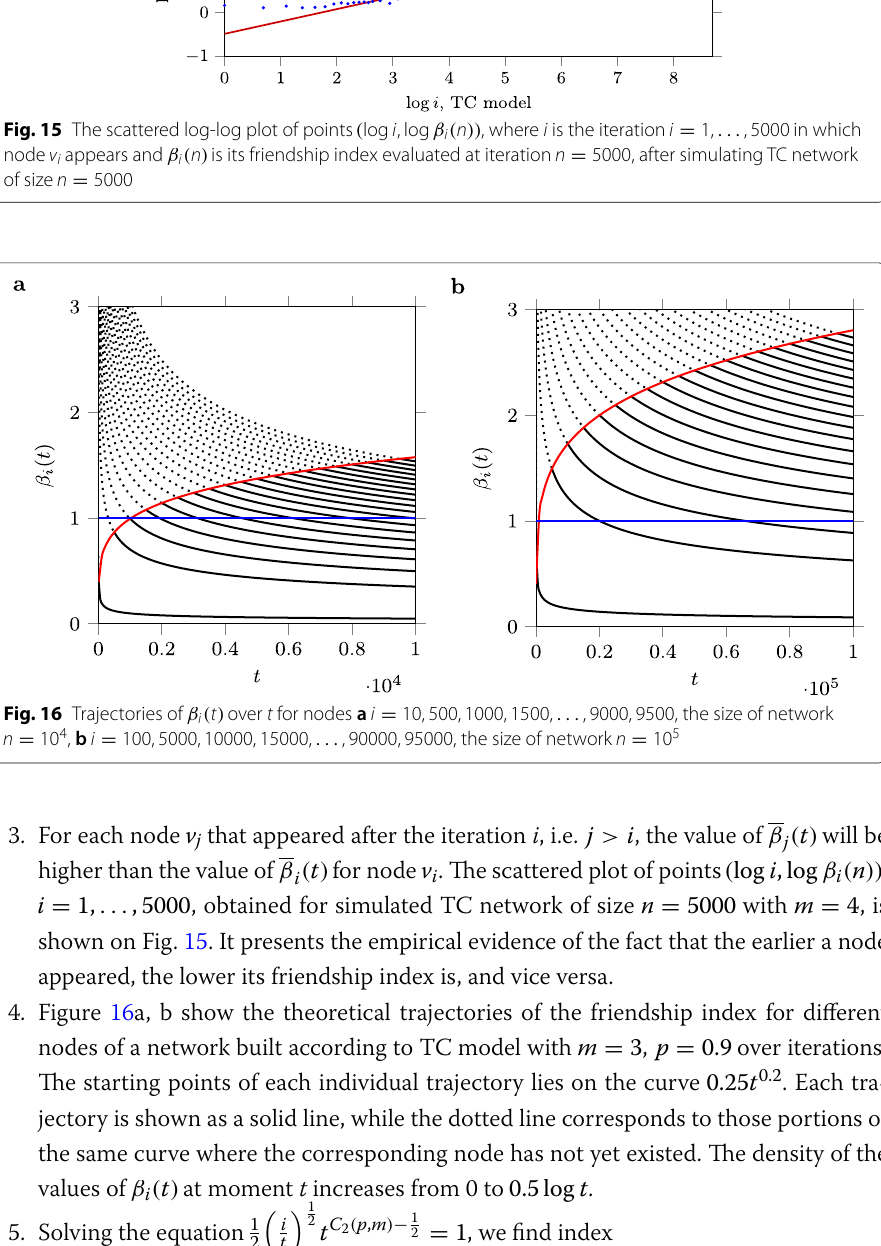
0.9 over iterations. 3 , p = = 0.2 . Each tra-